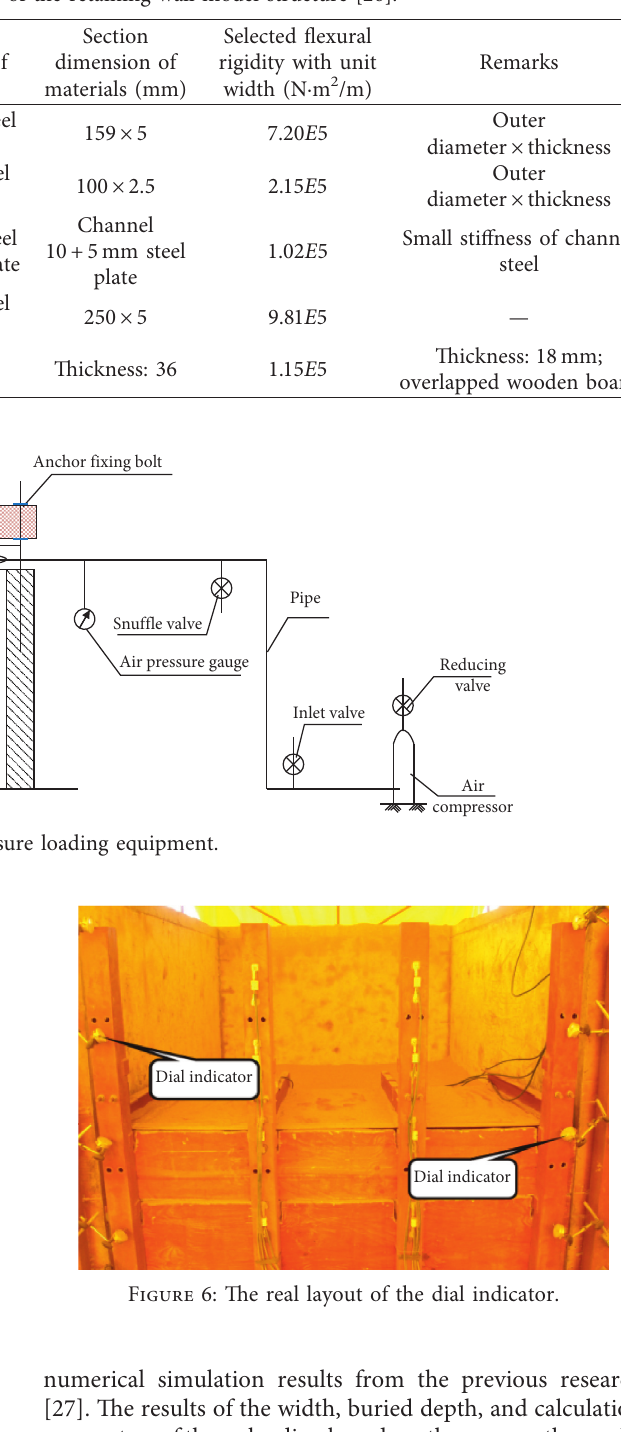
Table 2: The characteristic parameters of the retaining wall model structure [26].